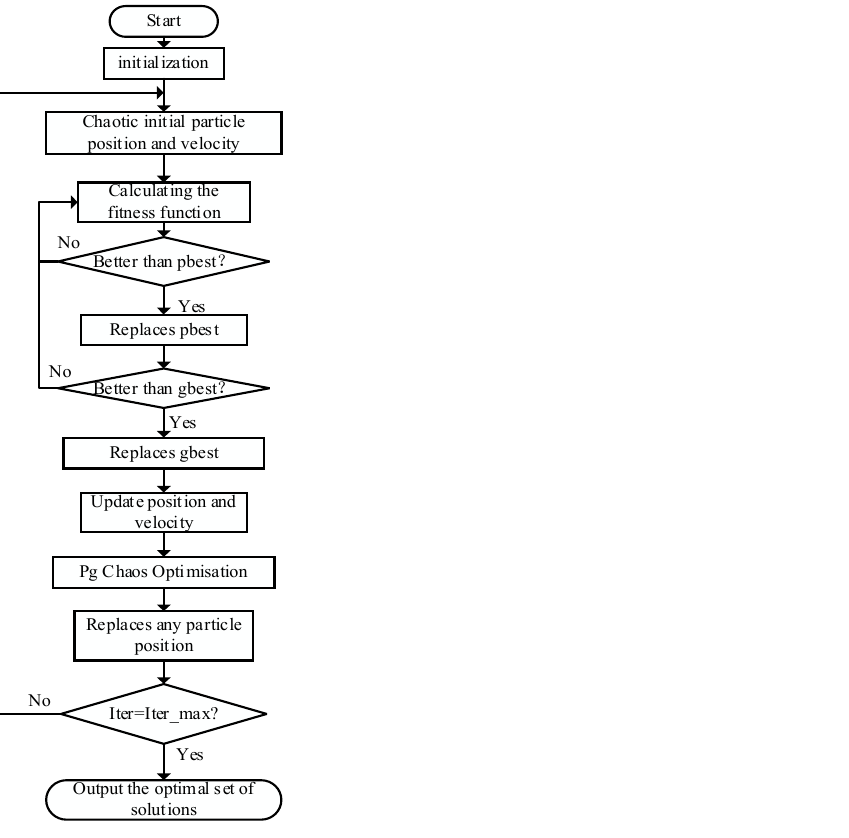
Figure 4. An MCPSO flow chart for solving the optimal HESS configuration. The detailed operations are shown as